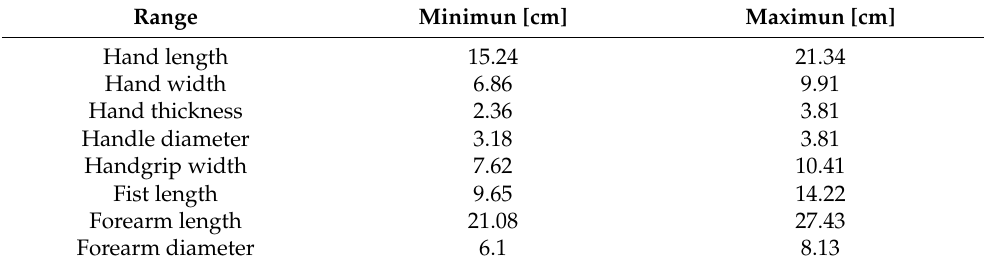
Table 2. Hand and forearm measurements and weights considered.